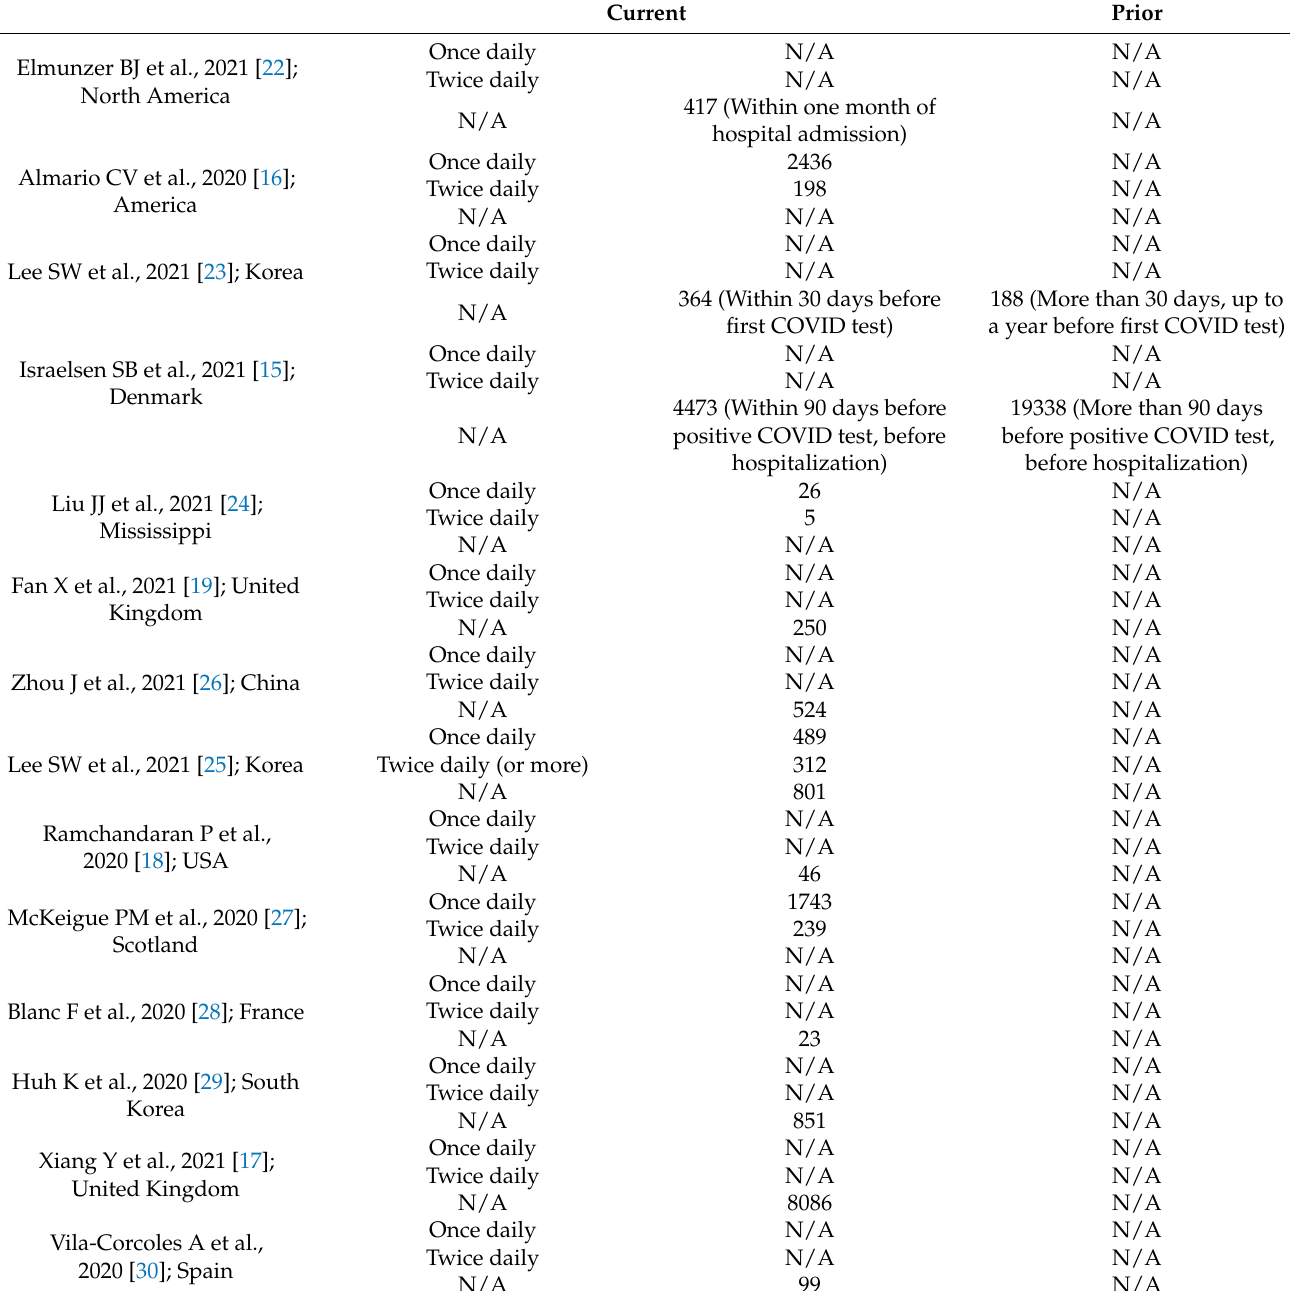
Table 3. Patient proton pump inhibitor (PPI)